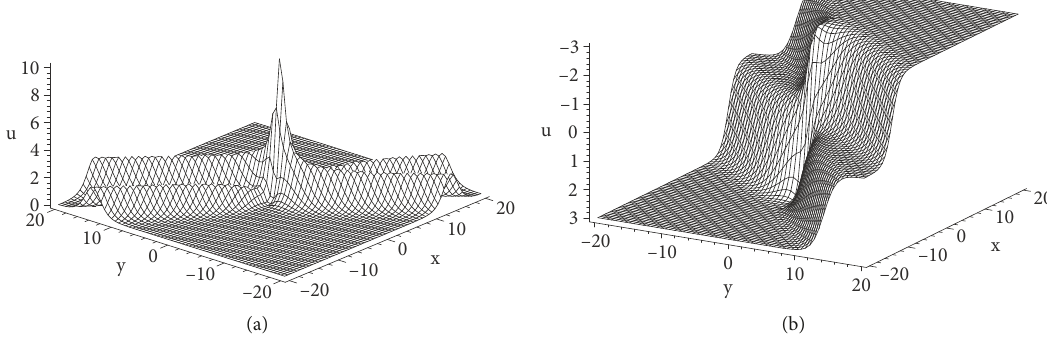
Figure 3: (a) 3-dimensional plot of the interaction solution between a lump and two solitons (19) with the time 𝑡 = 0 ; (b) 3-dimensional plot of the interaction solution between a lump and a two-kink soliton (20) with the time 𝑡 = 0